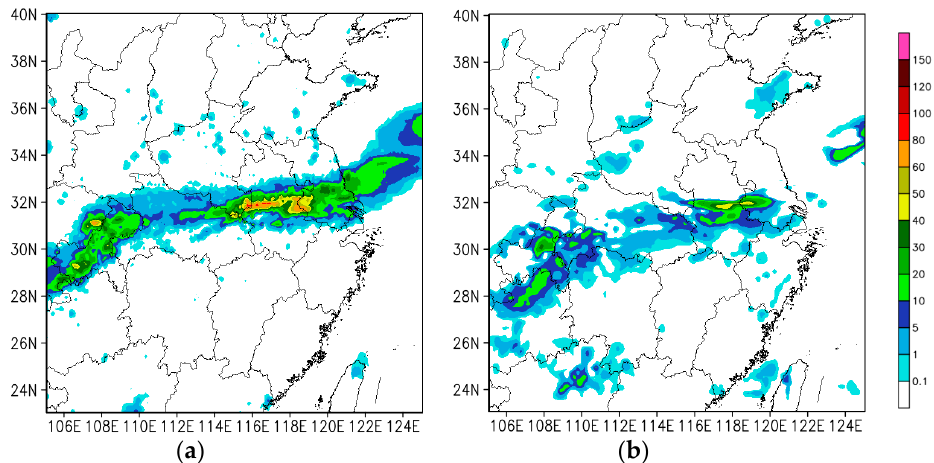
Figure 6. ( a ) Six-hour-accumulated rainfall observation initialized at 0000 UTC 05 July 2013, ( b ) Rainfall increments of the single rainfall observation test.